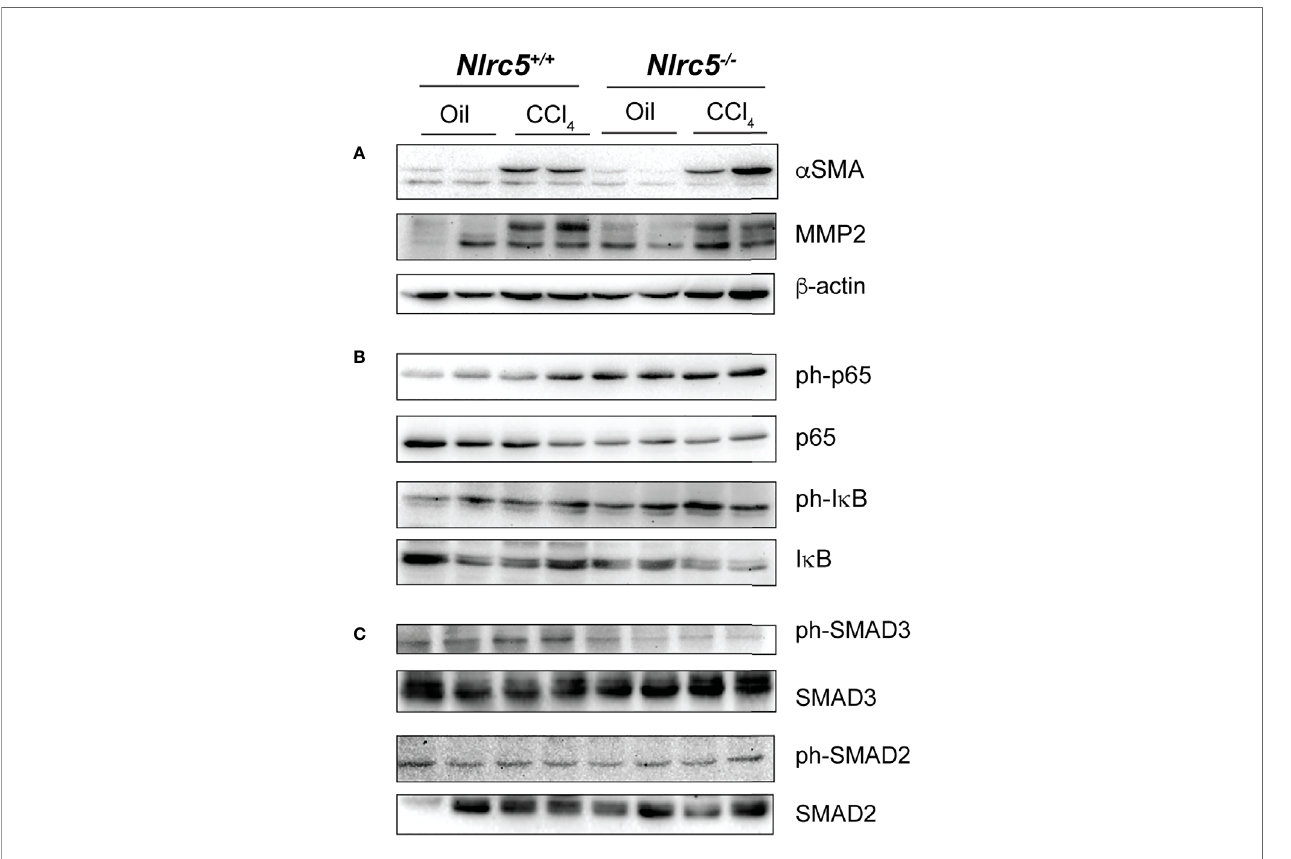
FIGURE 7 | NLRC5-de fi cient liversdisplay elevated levelsof phospho-p65 and diminished levelsof phospho-SMAD3. Liver tissue homogenates from control and NLRC5 -de fi cient liversfollowing treatment with CCl4orcorn oilwere evaluated for the expression of the indicated proteins associated with liver fi brosis (A) , NF- k B signaling (B) and TGF b signaling (C) . At least foursamples for each group frommore than two experiments were tested,and representative data for two mice per group are